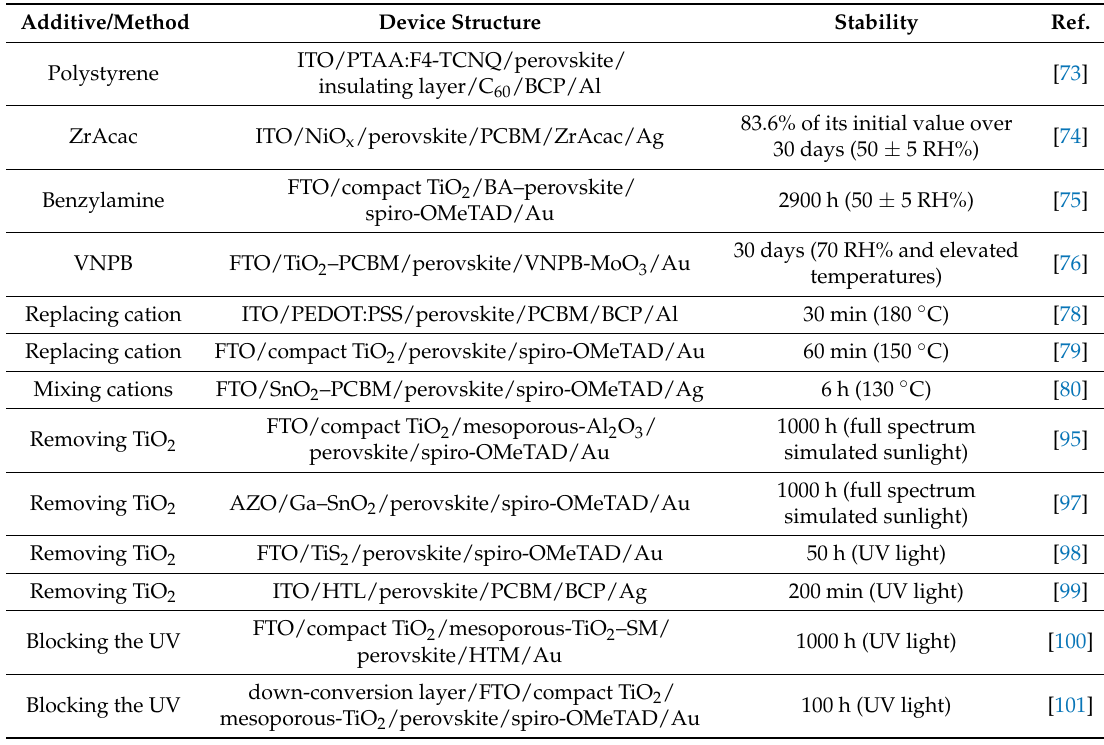
Table 4. Summary of literatures about stability of